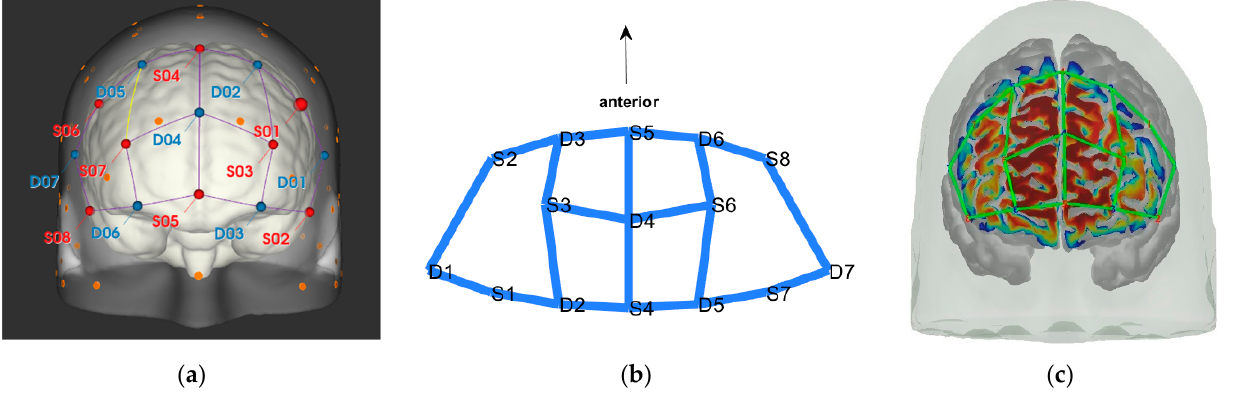
Figure 1. ( a ) The montage rendered onto the ICBM 152 Nonlinear atlases version 2009 [63,64], created with NIRSite 2020.7 (NIRx Medical Technologies). ( b ) The channels from above in an anterior orientation, created with NIRS toolbox [65]. ( c ) The sensitivity profile of the probe, created with AtlasViewer [62].